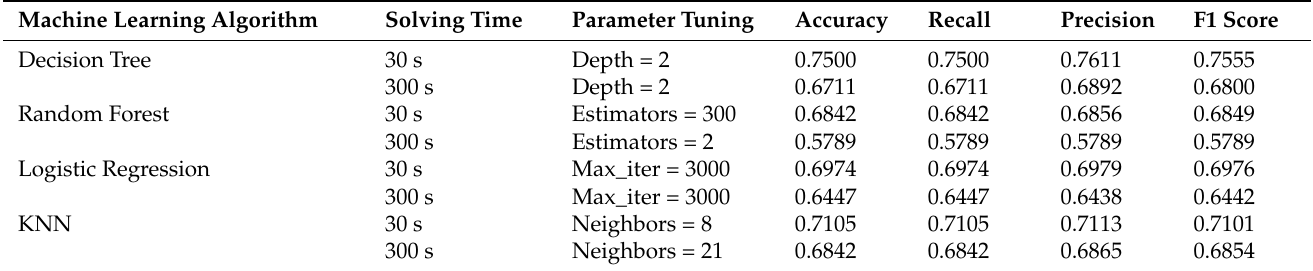
Table 8. Performance metrics of machine learning models for FJSSP datasets.